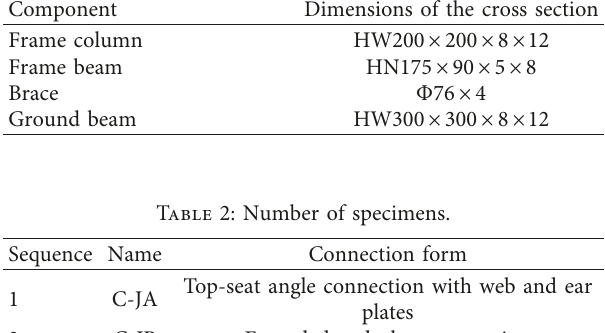
Table 1: Specification of the specimens (unit: mm). Component